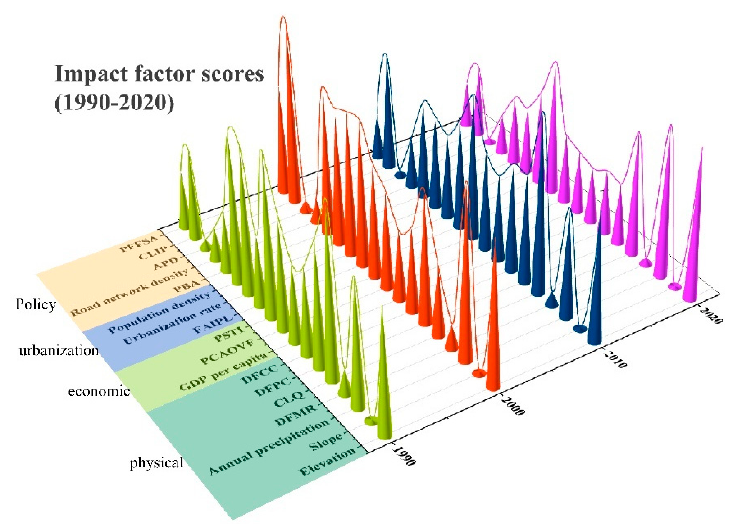
Figure 6. Impact scores for multi-functional factors affecting cultivated land in the black-soil bread- baskets of Jilin Province, Northeast China, from 1990 to 2020. The meanings of the abbreviations used in the figures are shown in Table 3. Table 6. Indicator values for factors influencing the multi-functionality of cultivated land in the black-soil breadbaskets of Jilin Province, Northeast China, from 1990 to 2020. Factor